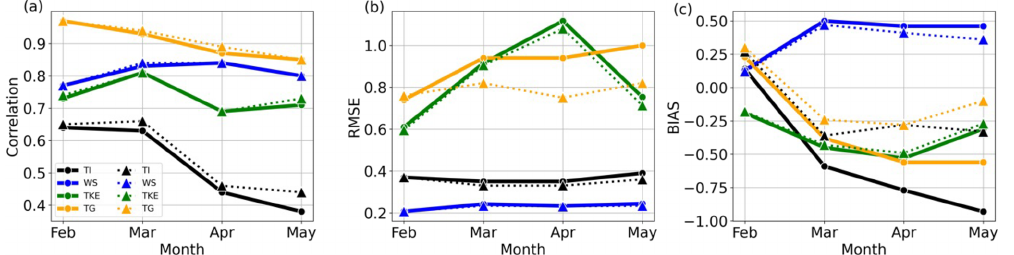
Figure 9. Metrics of the (a) correlation coefficient between the observations and simulations, (b) root mean square error (RMSE), and (c) bias for variables – TI, wind speed (WS), TKE, and air–sea temperature gradient (TG) – computed against the observations for each month between February and May in 2020. The dots with a solid line represent the baseline result. The triangles with a dashed line depict the corresponding values from the sstupdate